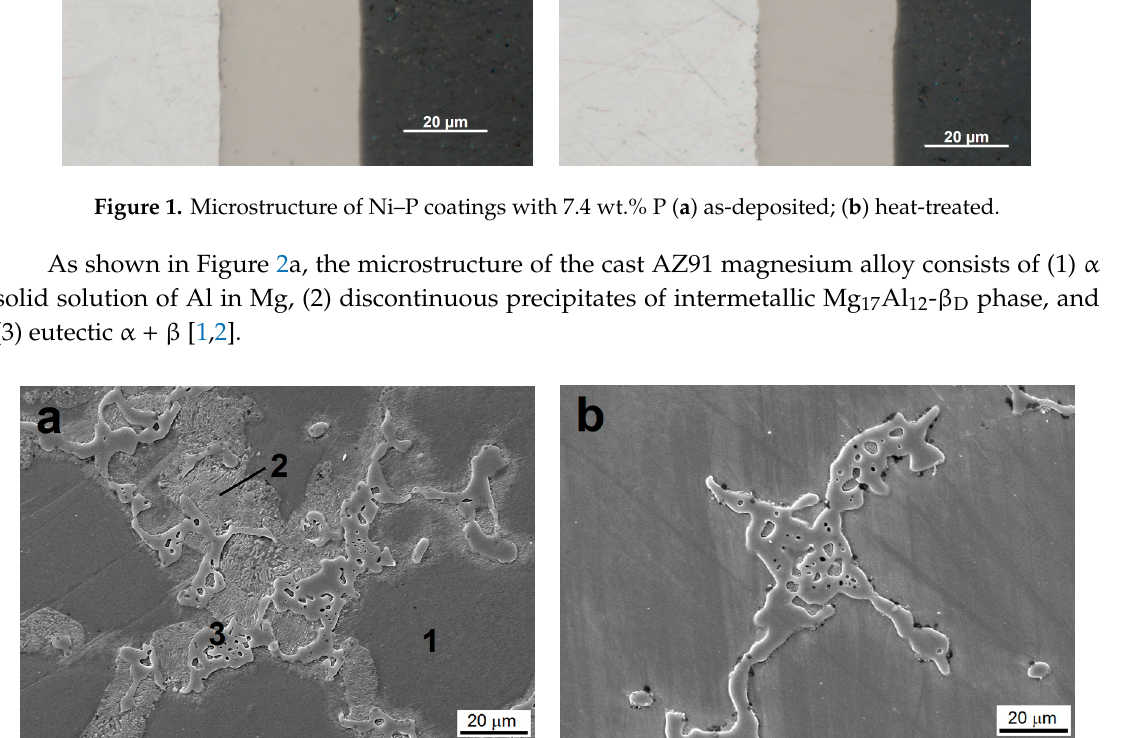
Figure 1. Microstructure of Ni–P coatings with 7.4 wt.% P ( a ) as-deposited; ( b ) heat-treated.